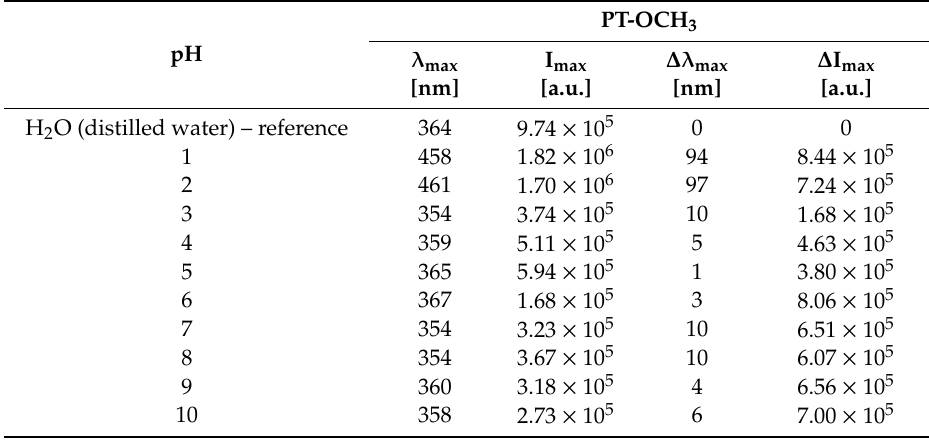
λ max-Fl —positionofmaximumfluorescenceintensity; I max —intensityofthefluorescenceat λ max-Fl ; ∆ λ max —di ff erence between the position of the maximum fluorescence of the PT-OCH 3 compound in the reference sample (in distilled water) and the maximum of fluorescence in bu ff ers at di ff erent pHs [nm]; ∆ I max —di ff erence between the maximum fluorescence intensity of the PT-OCH